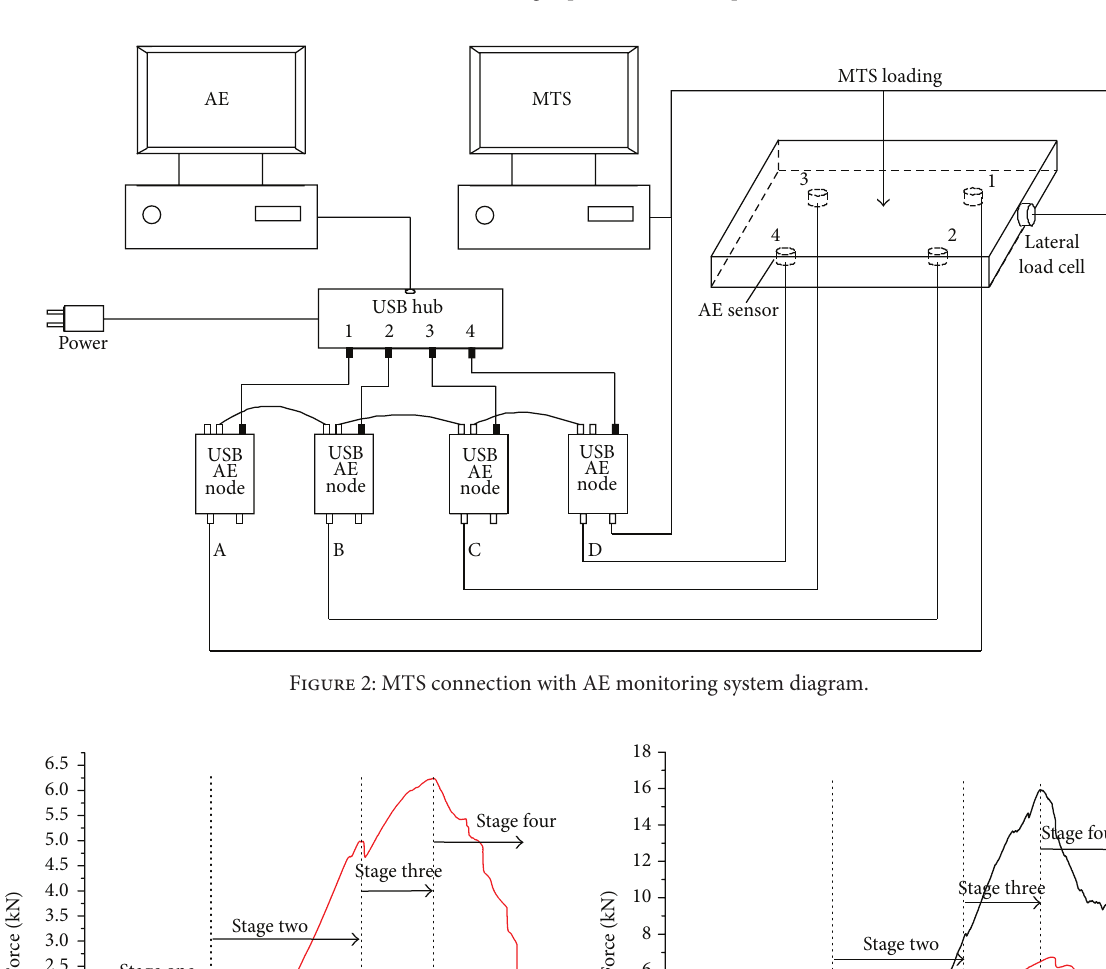
Figure 1: Loading experiment for rock plate.